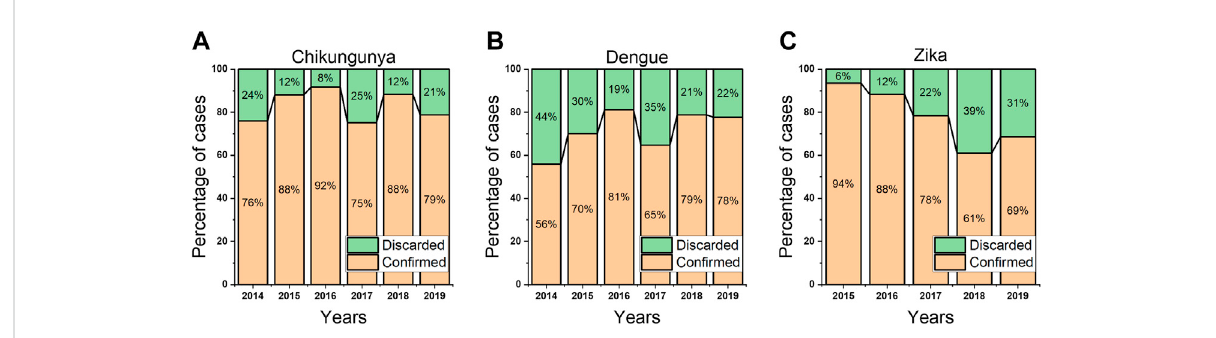
FIGURE 2 Percentage of cases discarded in the databases of each of the arboviruses for each analysed year. (A) Chikungunya. (B) Dengue. (C)